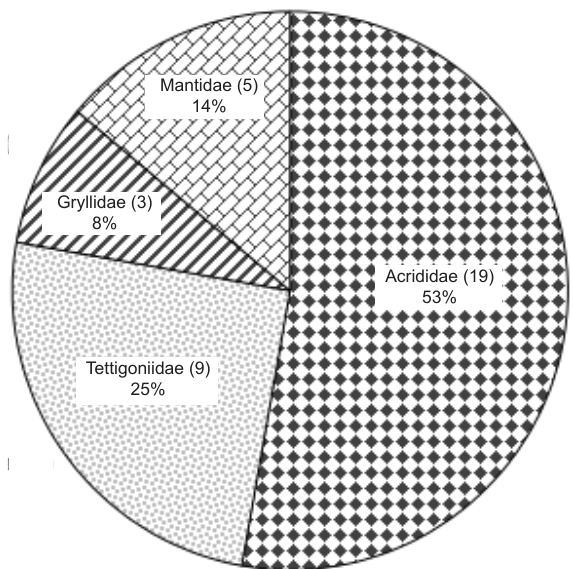
Figure 1. Orthopteroid faunal composiion in Kaziranga National Park, Assam